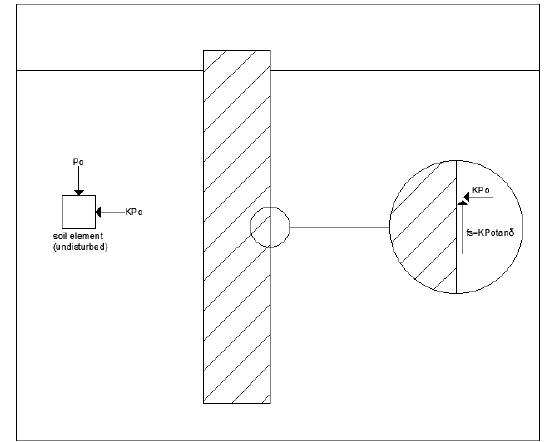
Figure 1. Skin friction force on the pile.